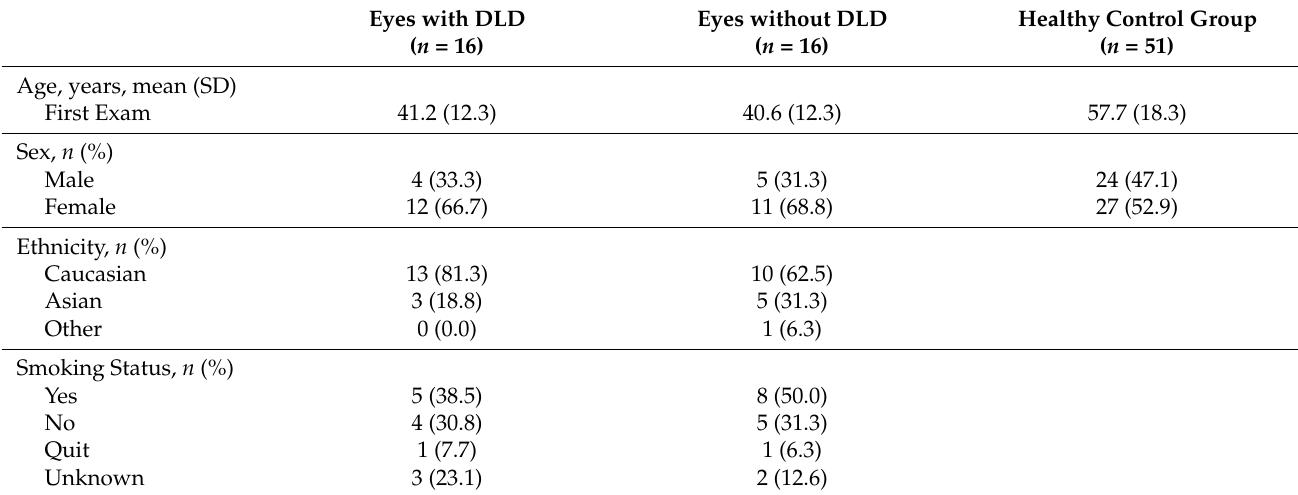
Table 1. Baseline demographics. SD, standard deviation.